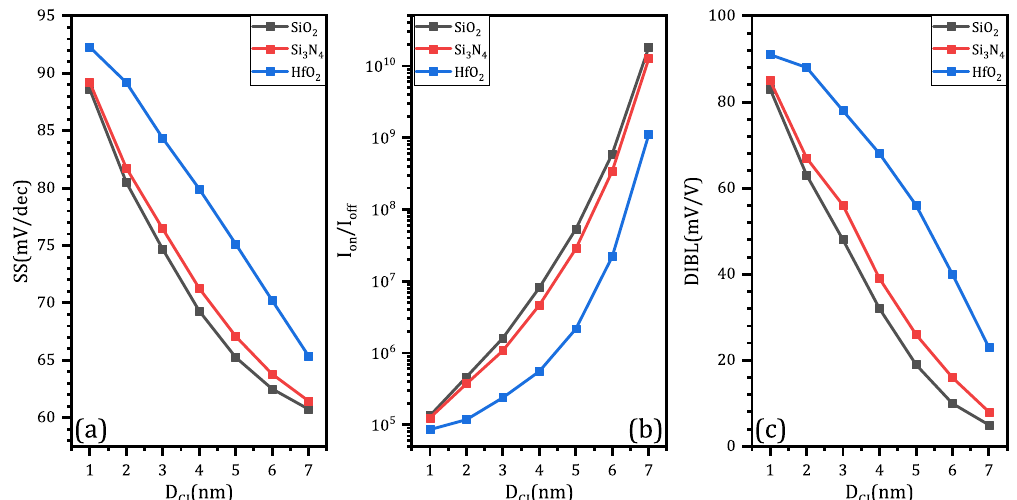
Figure 9. The simulation results of CIGAA and GAA in terms of different Core–Insulator material and D CI : ( a ) subthreshold swing (SS); ( b ) switching ratio (I on /I of f ); ( c ) drain-induced barrier lowering (DIBL). All three figures are plotted when D NW is fixed to 8 nm.